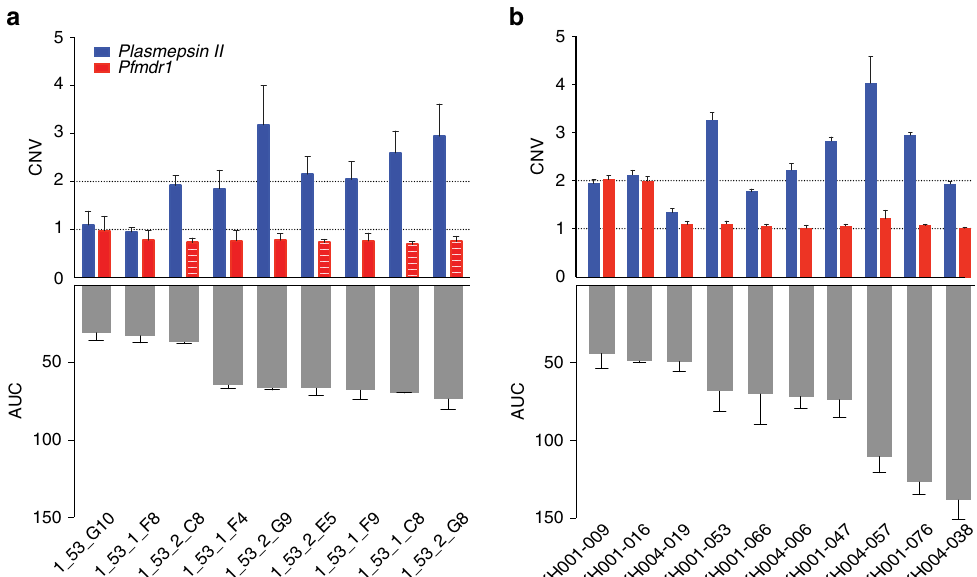
Fig. 4 Isogenic lines con fi rm association between plasmepsin II CNV and AUC. a Subclones of KH001_053, identical by a 24-SNP barcode (all clones) and WGS (3 sequenced clones), had variable plasmepsin II CNV levels but only a single pfmdr1 copy. b Isolates with > 90% relatedness vary in plasmepsin II and pfmdr1 CNVs. Plasmepsin II CNV levels correlated with AUC values, con fi rming that this locus has a role in conferring PPQ resistance. All drug assays were done in triplicate and repeated two times, shown are the means with s.d. CNVs are shown as mean + s.d. from three biological replicates done in quadruplicate by qPCR a or as average read depth of whole-genome sequencing + s.d. in